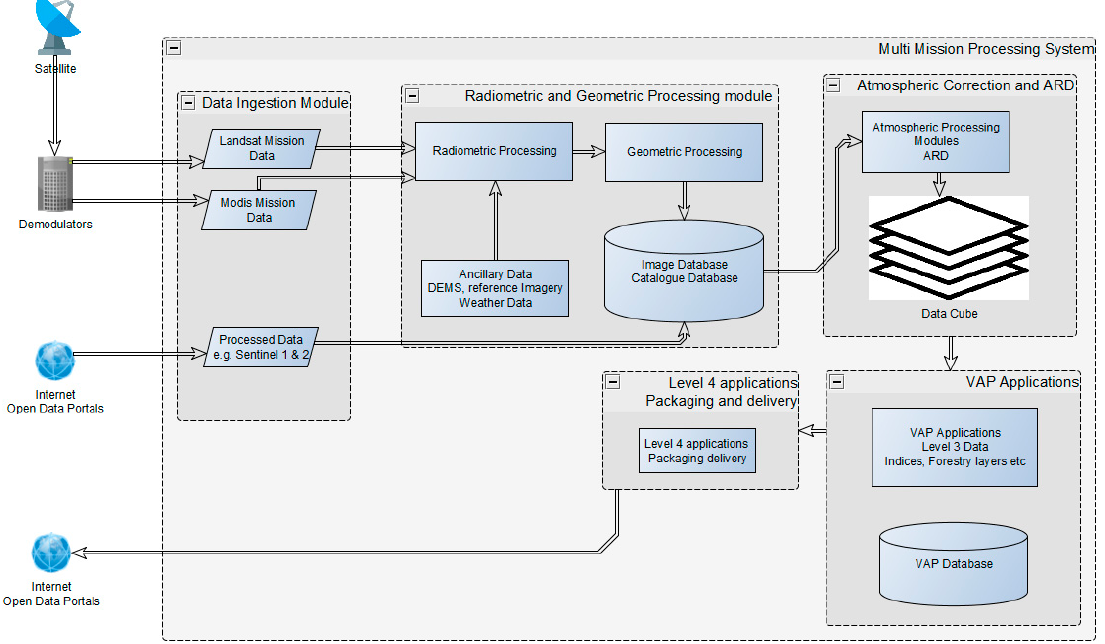
Figure 2. Implementation of the multi-mission processing system, which is comprised of four processing modules.